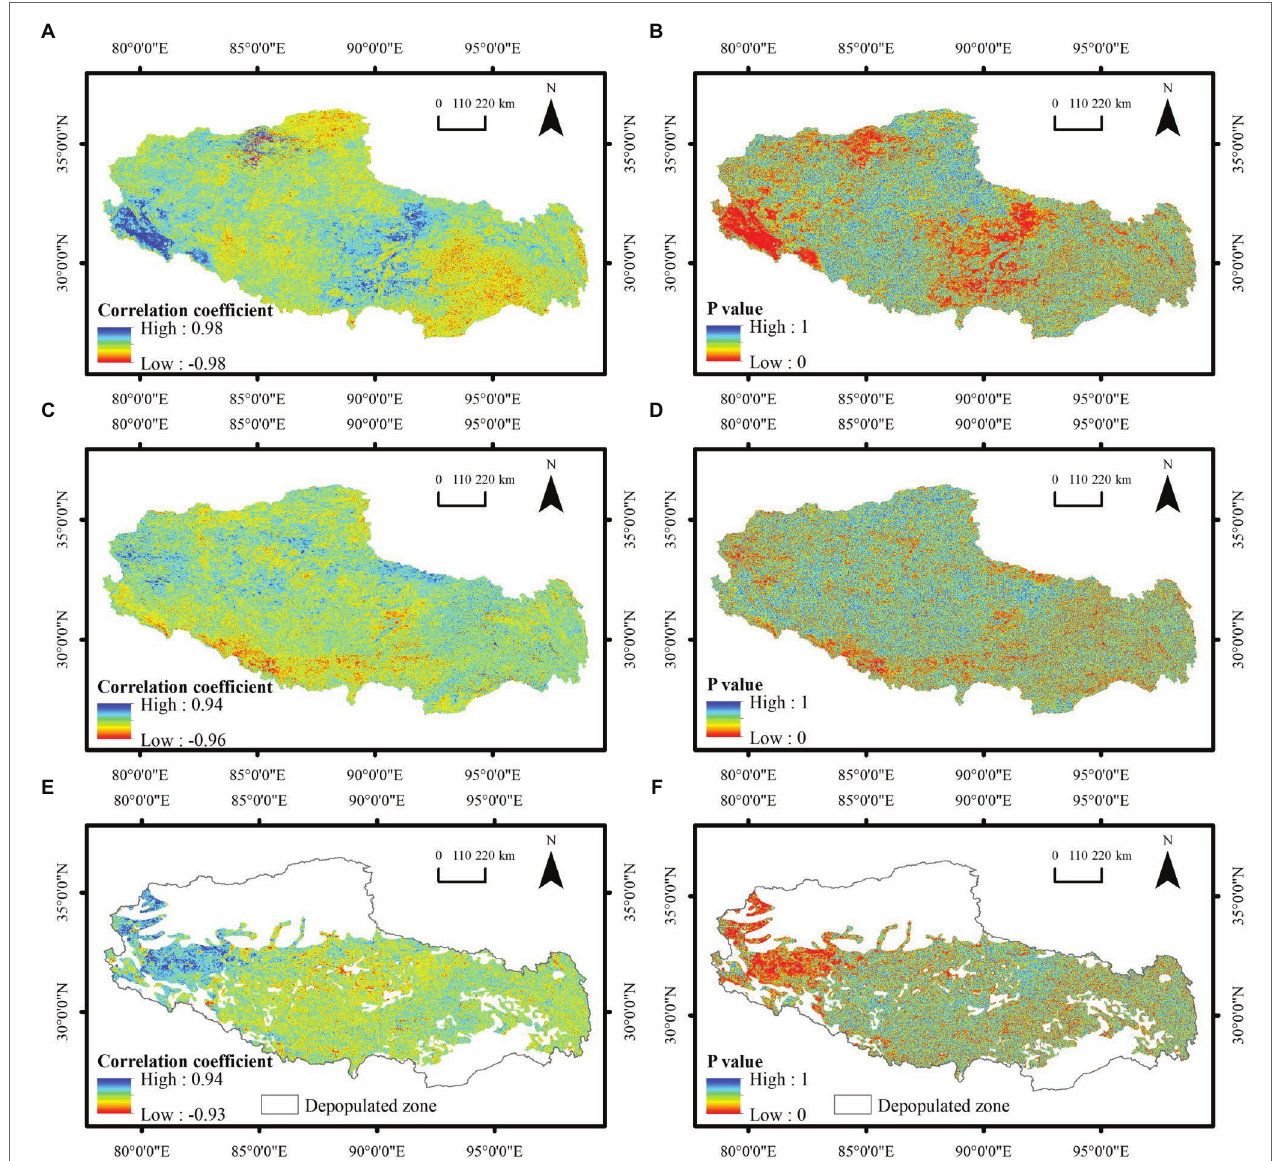
FIGURE 9 | Spatial distribution of the correlation coefficient values and significance between the NDVI and (A) , (B) annual cumulative precipitation, (C) , (D) annual average temperature, and (E) , (F) annual population density in Tibet from 2001 to